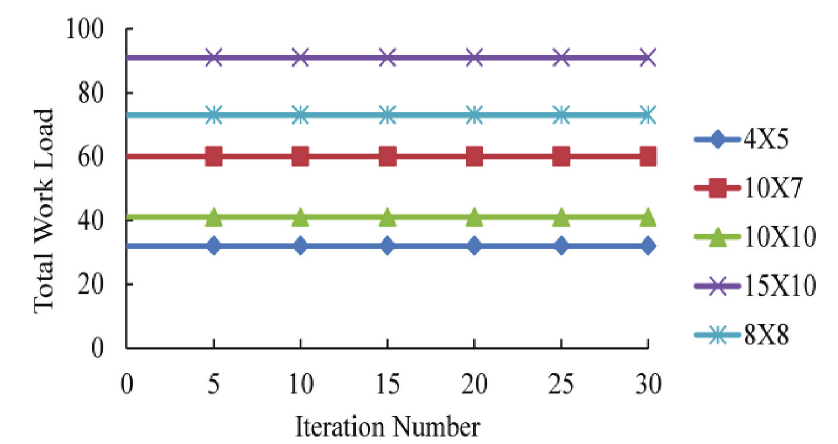
Fig. 9 Convergence curve for Kacem instances